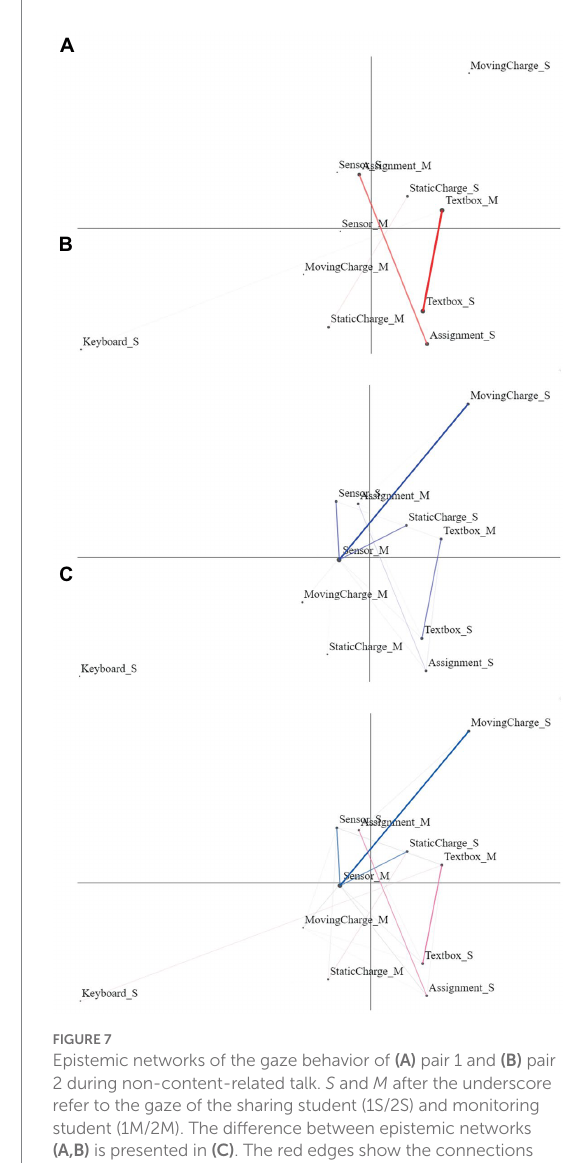
FIGURE 6 Epistemic networks of the gaze behavior of (A) pair 1 and (B) pair 2 during silent moments. S and M after the underscore refer to the gaze of the sharing student (1S/2S) and the monitoring student (1M/2M). The difference between epistemic networks (A,B) is presented in (C) . The red edges show the connections between the nodes that were stronger among pair 1 than among pair 2. The blue edges show the connections between the nodes that were weaker among pair 1 than among pair 2.